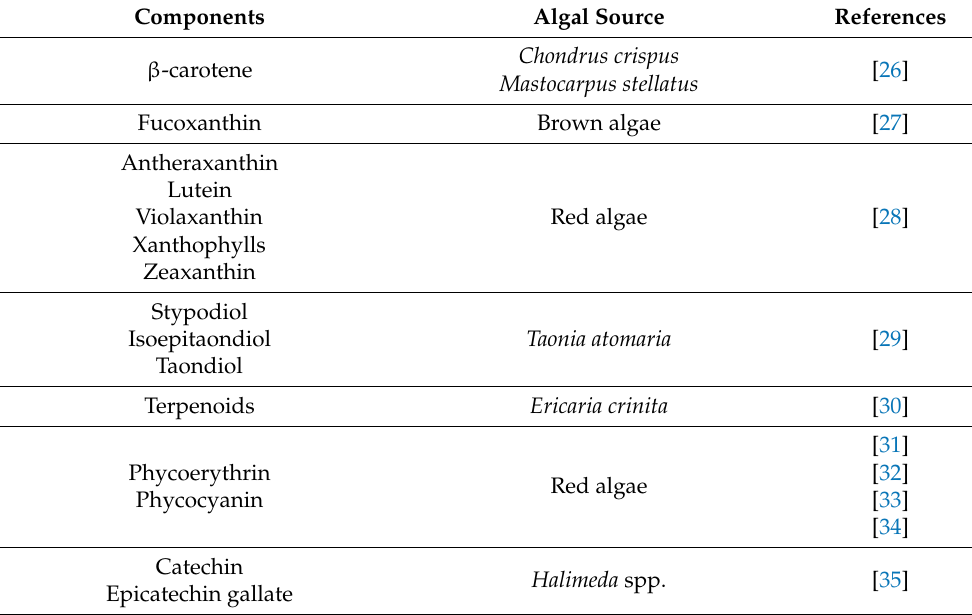
Table 2. Main groups antioxidants in